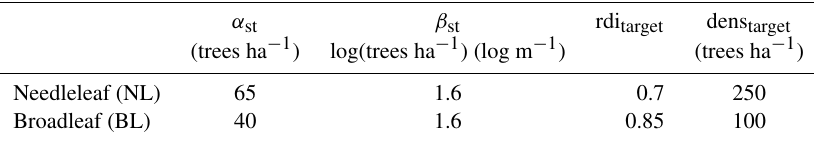
Table A3. Parameters for automated thinning and